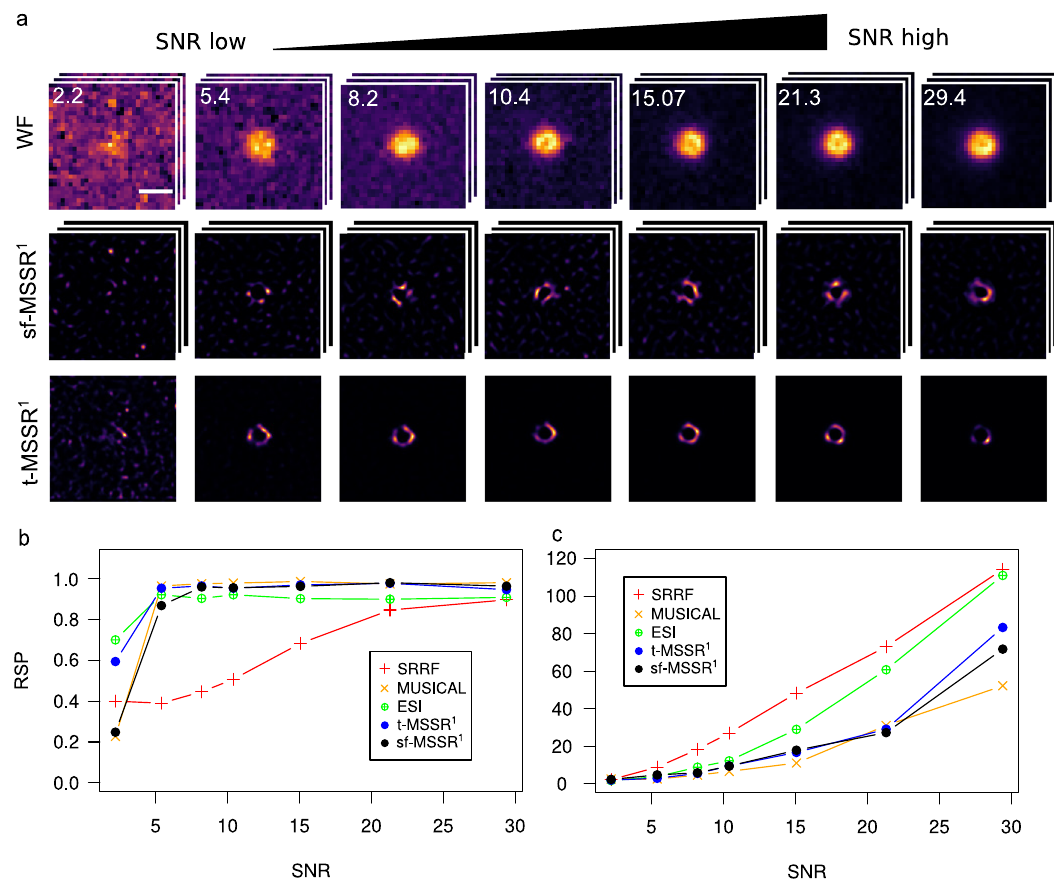
Fig.8|MSSRisrobusttoimagenoiseandshowshighglobalperformancewhen compared to other SRM analytical procedures. a sf-MSSR 1 and t-MSSR 1 of 100 images provide consistent reconstructions across a wide range of SNR. The expected feature is a uniform fl uorescent ring located at the center of the image with a dark background lacking fl uorescence. Each image is displayed to show its full intensity range. The row for DL images (Wide fi eld, WF) exempli fi es a stack of 100 frames collected at the corresponding SNR. The central row represents an extended-resolved stack using sf-MSSR 1 , AMP=4, FWHM of PSF=2.77, order=1. The third row shows the super-resolved micrography after t-MSSR 1 analysis of 100